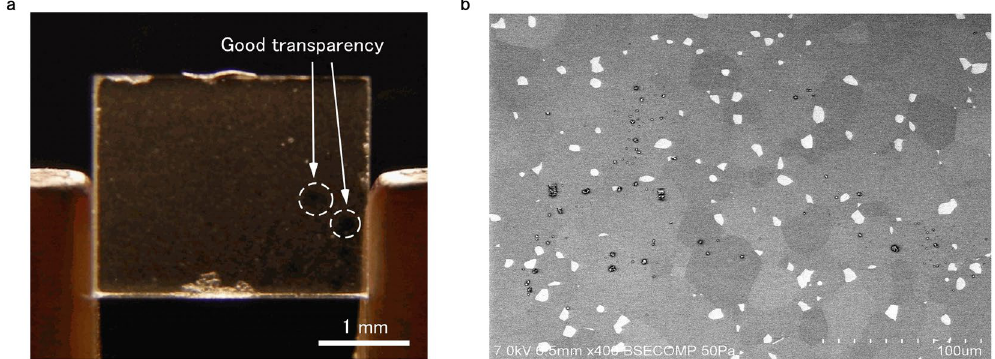
Figure 4. ( a ) Photograph and ( b ) SEM image of Yb:FAP with quantum-controlled microdomains.